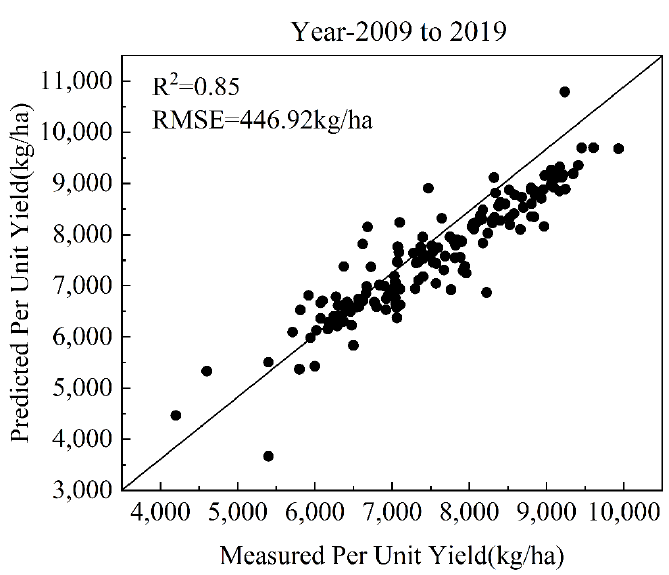
Figure 6. Accuracy of per unit yield for ten years.